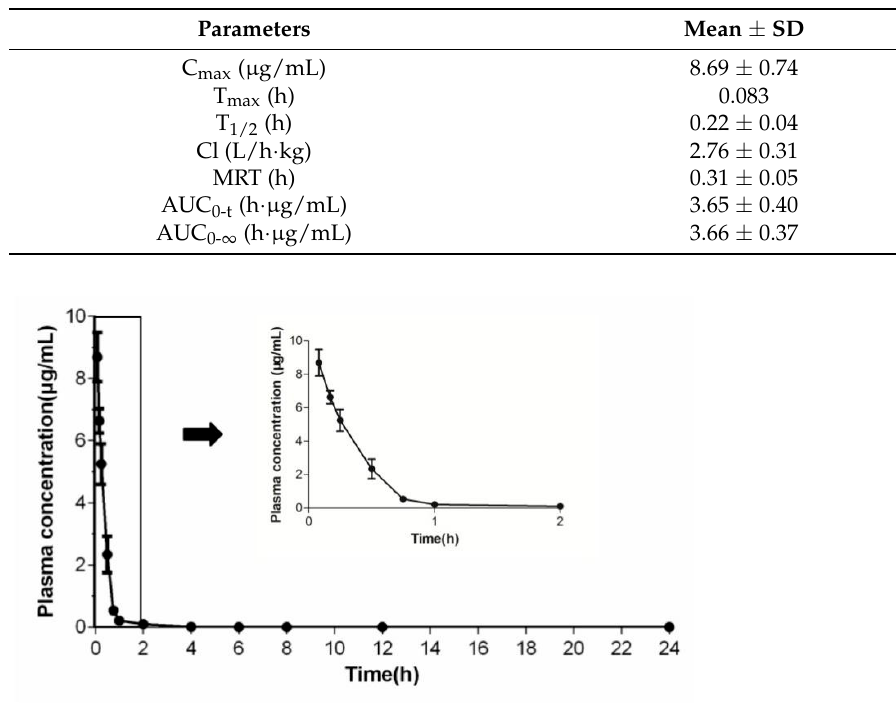
Figure 8. The plasma concentration–time curve of NPDM after intravenous